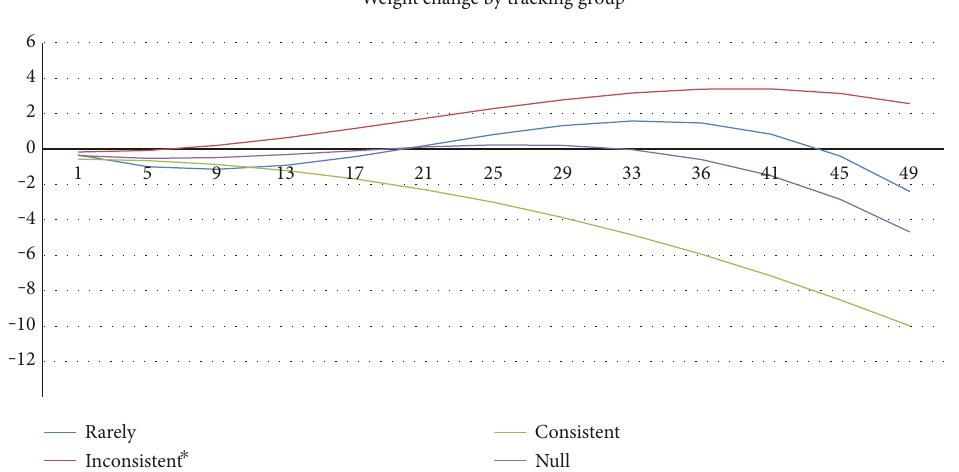
Figure 3: Predicted weight loss, in pounds, over time across tracking groups, from week 2 to week 49, holding all other variables constant. Inconsistent curve is not statistically di ff erent from the rare curve. Week 9 is the thanksgiving week and the beginning of the holiday season, and weight begins to climb. Week 33 is the beginning of summer (June), and we see weight start to drop again. However, consistent trackers do not experience these changes and sustain steady weight loss throughout the year. ∗ Nonsigni fi cant.